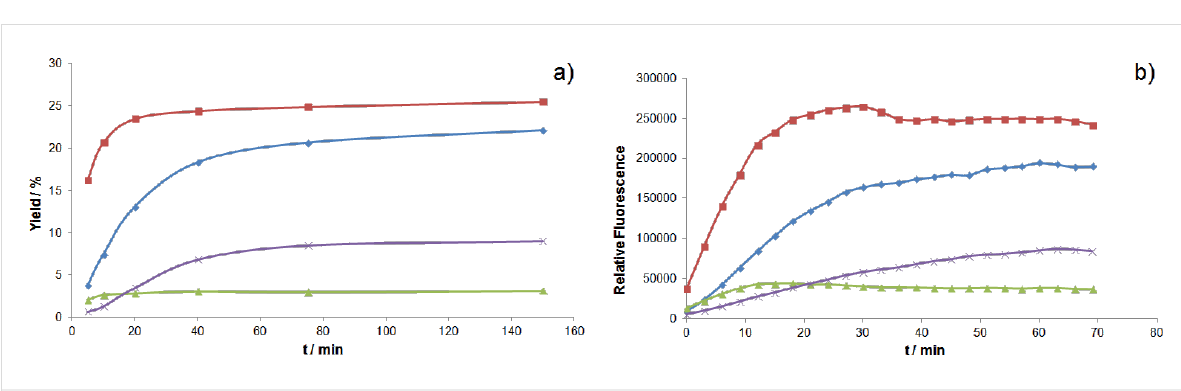
measured on a Bruker maXis 4G QTOF-ESI spectrometer. HPLC was conducted on a Waters Acquity H-Class Bio UPLC device, using a BEH C-18 reversed-phase column. Starting